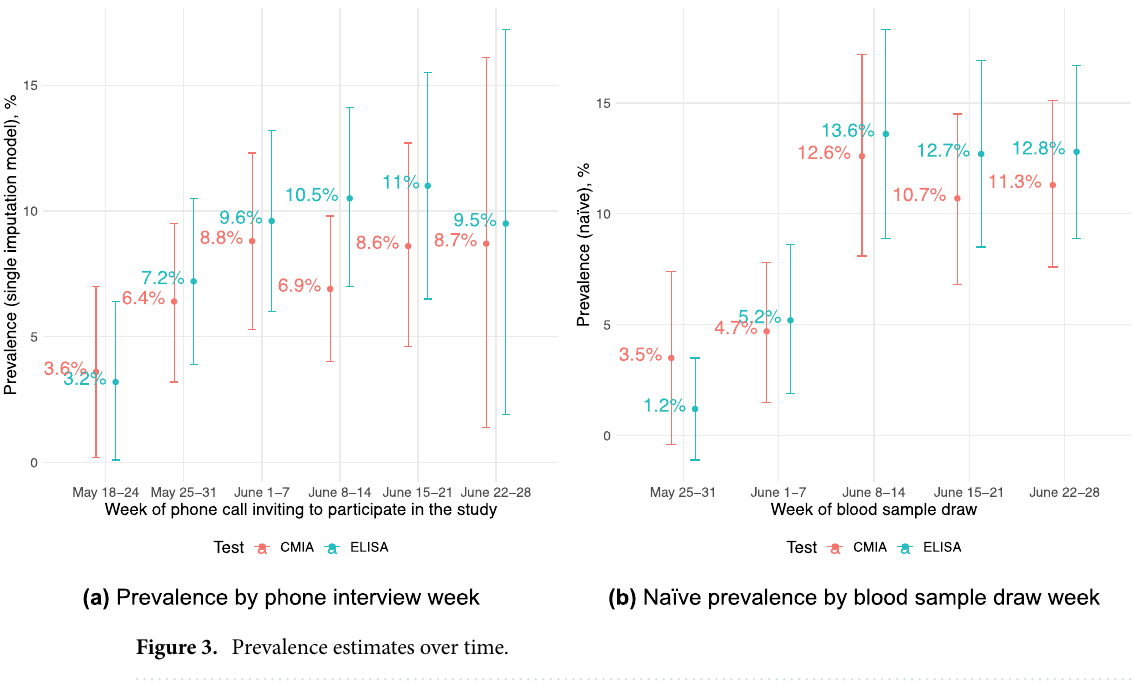
Figure 3. Prevalence estimates over